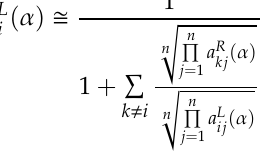
Figure 2. Procedure of the proposed methodology.